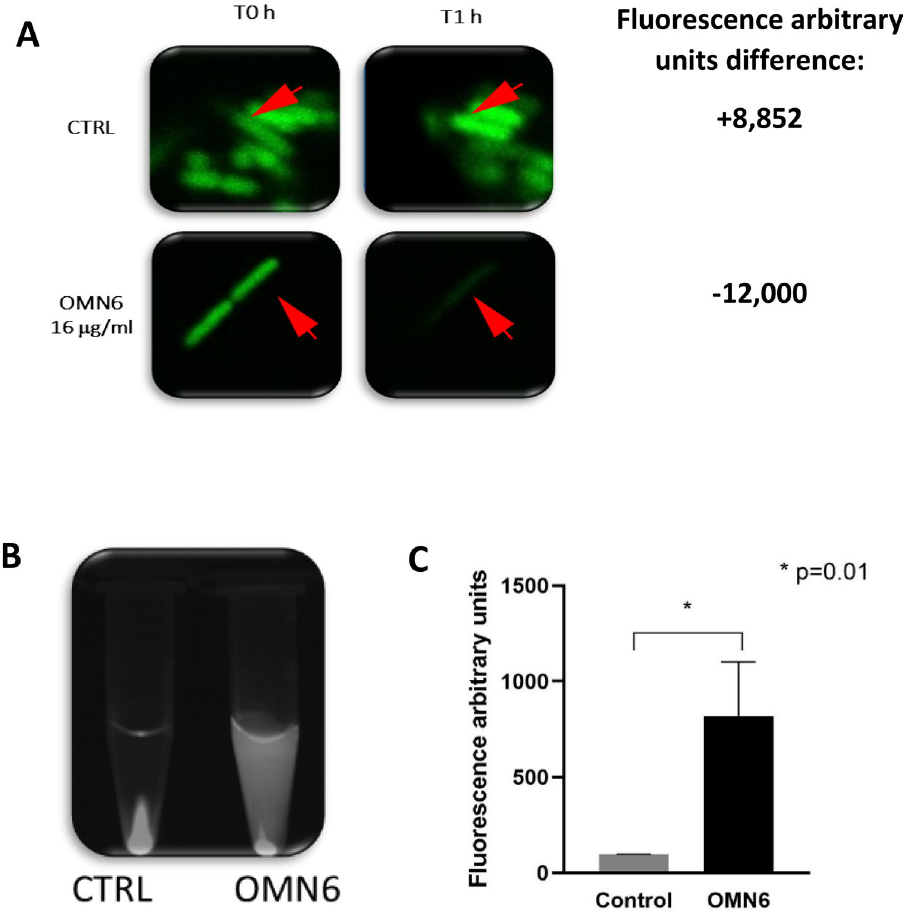
Figure 2. OMN6 mechanism of Action studies using the E. coli GFPuv model. ( A ) E. coli GFPuv bacteria were treated with double-distilled water (upper panels) or 16 µg/mL OMN6 (lower panels). Bacteria were monitored via confocal microscope at a 488 nm wavelength. During the experiment, levels of Florescence Units were continuously documented for a single bacterium (indicated by arrow). ( B ) E. coli GFPuv were treated with double-distilled water or 50 µM OMN6 and centrifuged at 5000 rpm after incubation. Experiment tubes were visualized under UV light. ( C ) Levels of fluorescence arbitrary units in the supernatants were quantified after a 96-well plate reader excitation at 395 nm and emission at 509 nm (*p =